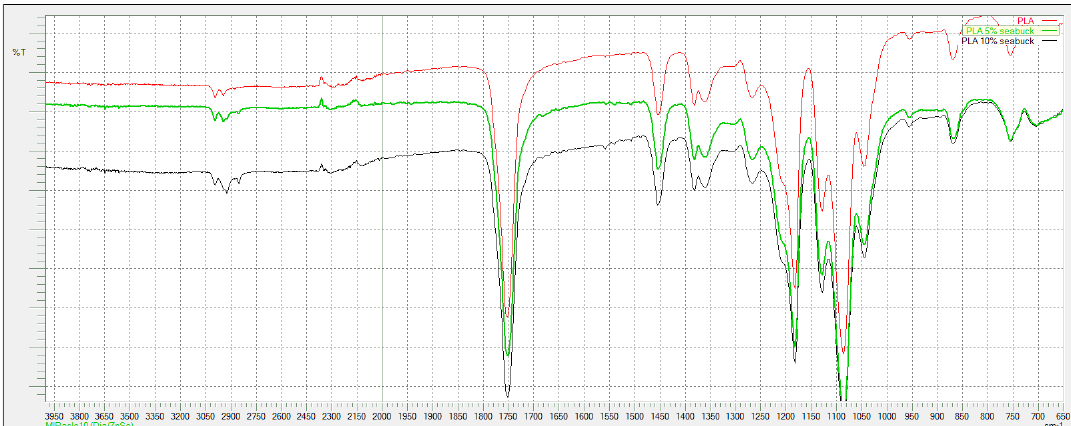
Figure 4. ATR-FTIR spectra of PLA, PLA-5SB, PLA-10SB.